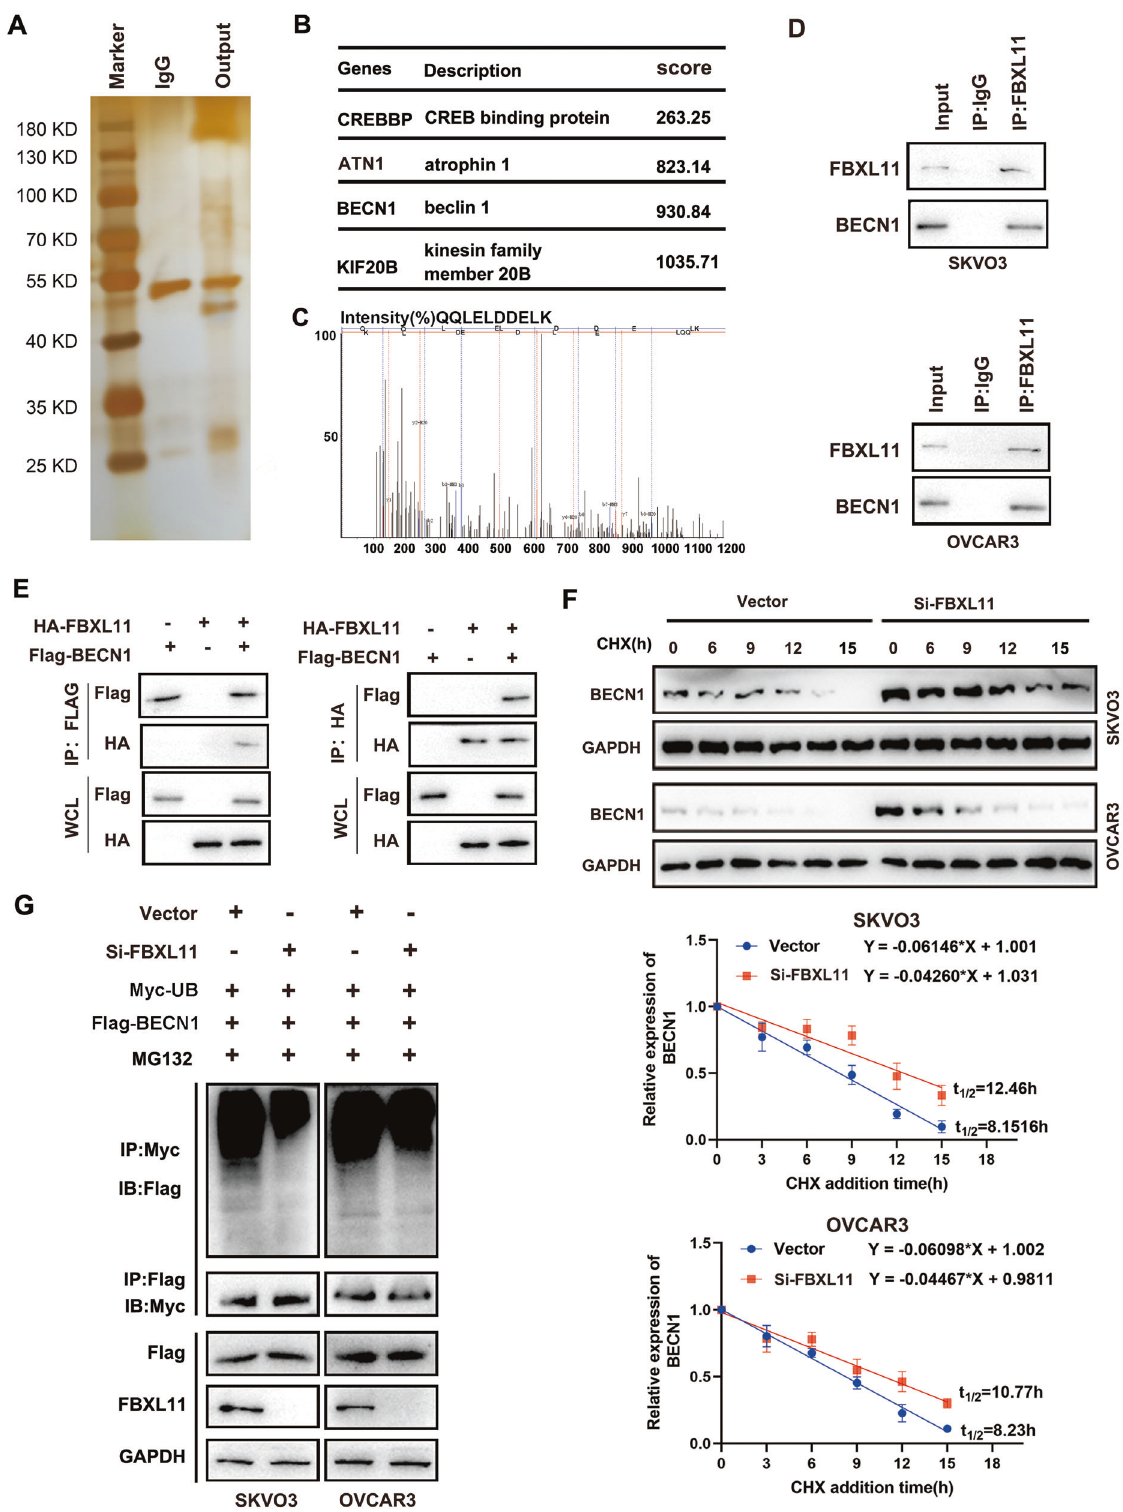
Fig. 7 FBXL11 increased the ubiquitination of Beclin-1 in OC cells. A Silver staining indicated protein binding with FBXL11. B Top 4 interacting proteins with FBXL11 are shown. C The secondary mass spectrograms indicated BECN1 binding with FBXL11. D Endogenic immunoprecipitation indicated the binding between FBXL11 and Beclin-1. E Ectogenic immunoprecipitation indicated the binding between FBXL11 and Beclin-1. F CHX was used to inhibit protein synthesis, and degradation of Beclin-1 was detected in SKOV3 and OVCAR-3 cells with FBXL11 knockdown and control. G The ubiquitination level of Beclin-1 in SKOV3 and OVCAR-3 cells with FBXL11 knockdown and control was detected.